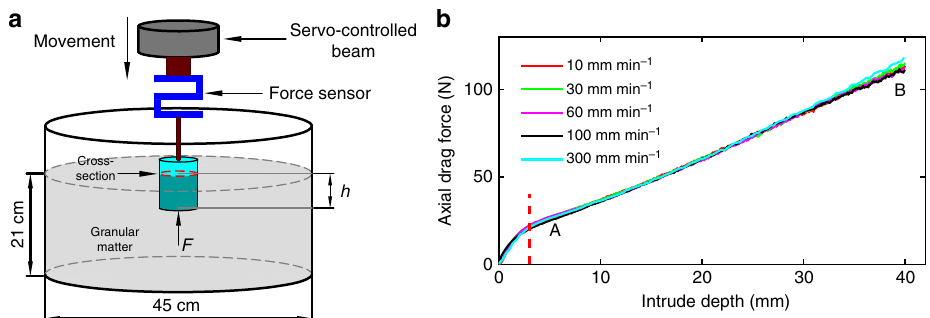
Fig. 1 Experimental setup and validation of the quasistatic regime. a Sketch of the experimental apparatus. An intruder is connected to the servo-controlled beam through a force sensor. The intruder is inserted into the granular medium at constant low velocity, while the vertical displacement and total vertical resistance force are continuously recorded. b The raw data for the vertical resistance force on a cylindrical of diameter D = 40 mm and length L = 50 mm, penetrating quartz sand with different velocities, ranging from 10 mm min − 1 to 300 mm min − 1 . The independence of the velocity indicating the quasistatic state of the experiment. The red dashed line marks the end of the transient